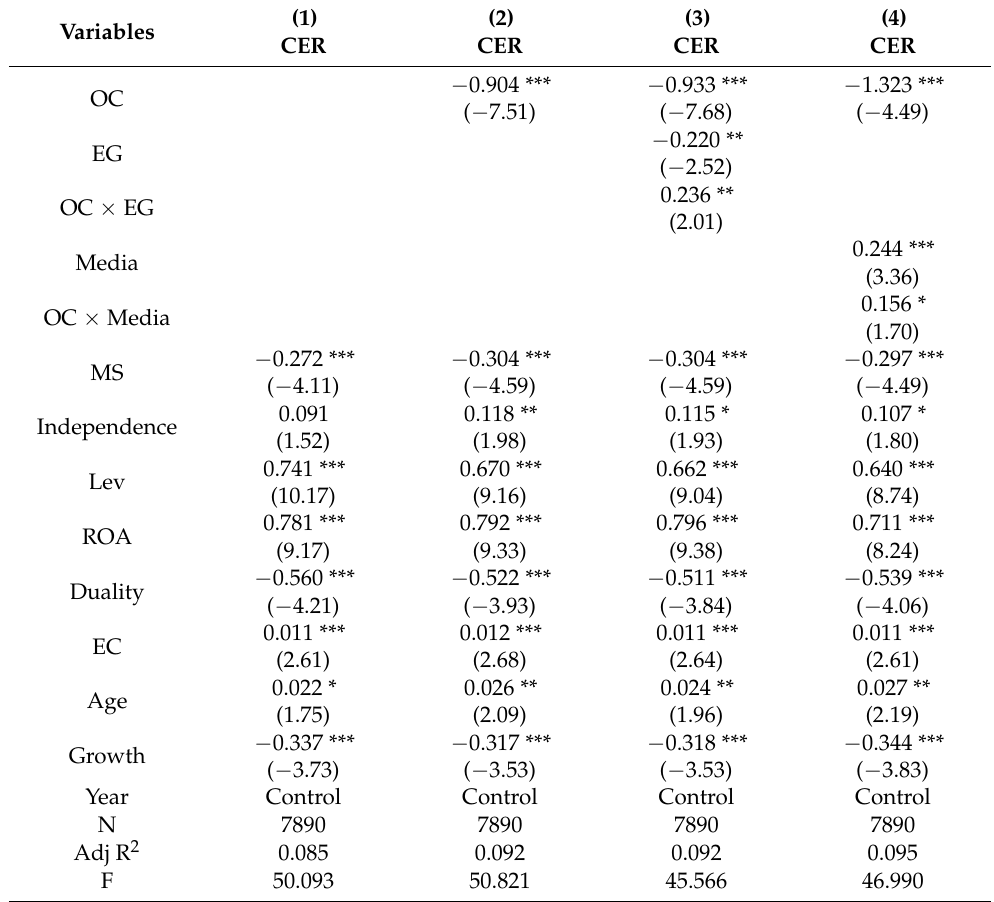
Table 5. Regression results